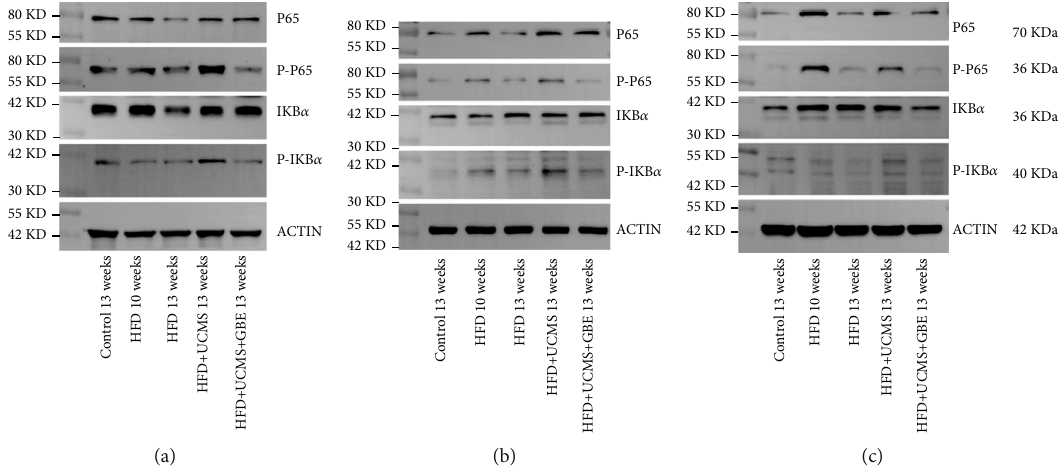
Figure 8: Hippocampus, cortex, and hypothalamus in fl ammation by western blotting. (a) The expression of P65, P-P65, I κ B, and P-I κ B in the hippocampus by western blot; (b) the expression of P65, P-P65, I κ B, and P-I κ B in the cortex by western blot; (c) the expression of P65, P- P65, I κ B, and P-I κ B in the hypothalamus by western